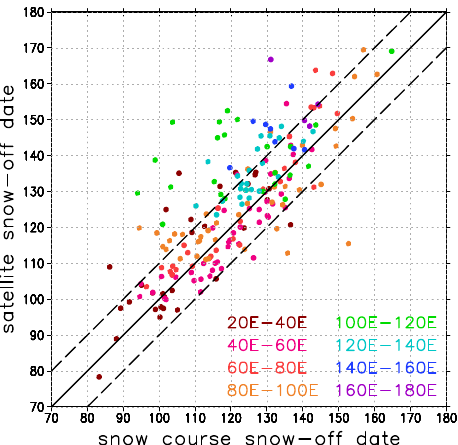
Figure 2. The relationship between time-mean snow-off dates based on the snow course data and the satellite retrievals. The satellite snow-off dates were averaged to the T63 horizontal resolution and screened according to the availability of snow course data. Only those grid cells for which the snow-off date in the snow course data could be determined for at least 5 years during 1979–2006 are in- cluded. The data points are colour-coded according to longitude. The solid diagonal line indicates equal snow-off dates for the two data sets, while the dashed diagonals correspond to a difference of ± 10